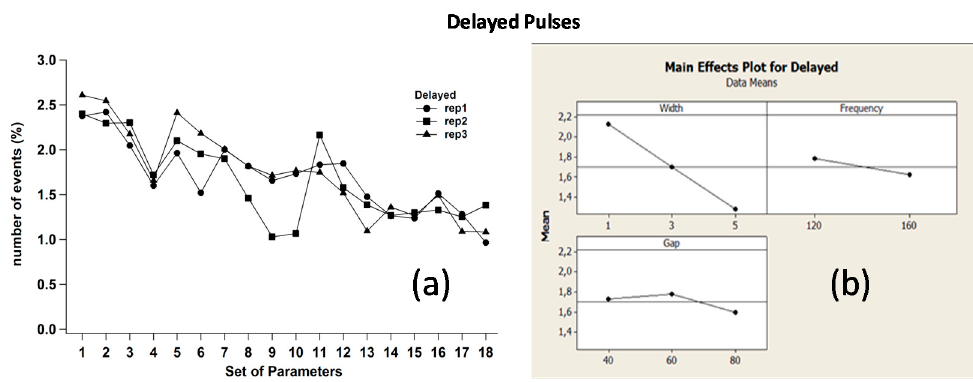
Figure 9. ( a ) Replica diagrams and ( b ) main effects plot related to delayed pulses.